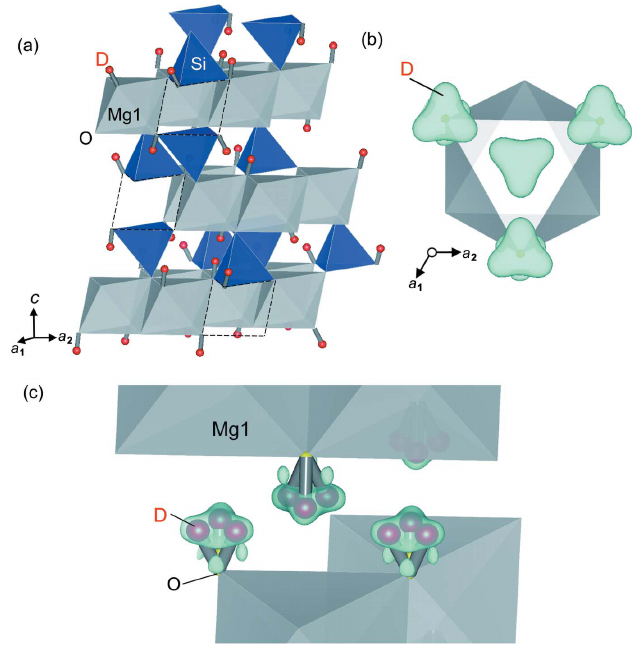
Figure 2 Refined structure of DHMS phase E. ( a ) Framework structure along with tilted O—D dipoles. No cation was found at the Mg2 site. Vacancies of MgO 6 octahedra (dashed area) are coupled with two adjacent SiO 4 tetrahedra crosslinking the neighboring layers. The proposed locations of D + are shown as red spheres. ( b ) Difference Fourier map projected from the c axis orientation. The locations of D + were determined along with refininement of the site occupancy factor to the corresponding nuclear density distributions. There are three equivalent sites of D + around each O 2 (cid:2) ion. ( c ) Geometry of chemical bonding in the interlayer space O— D (cid:5)(cid:5)(cid:5) O. Because of the site symmetry, three equivalent sites of D + are observed simultaneously around each O 2 (cid:2) , while one of them is actually filled by D +